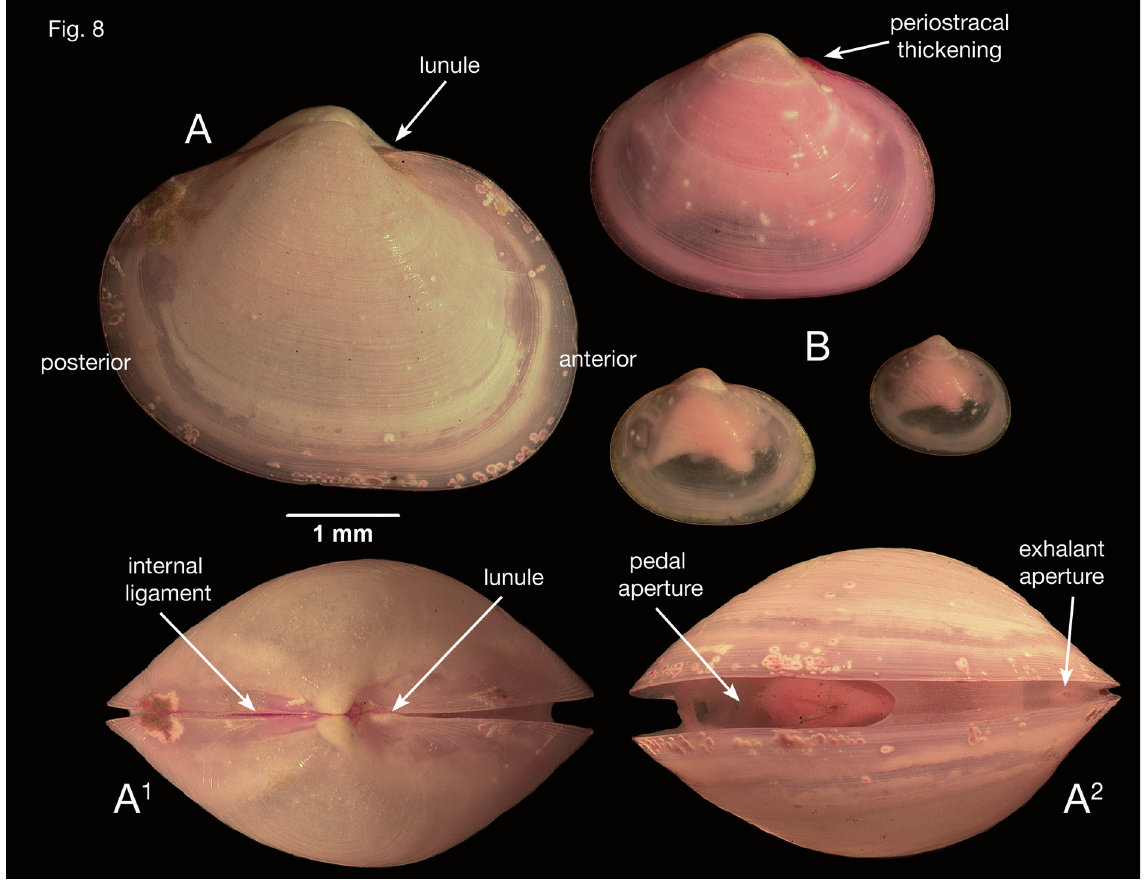
Fig. 8. Computer enhanced photomicrographs of whole specimens of Syssitomya pourtalesiana sp. nov. from the Norwegian Sea. A-A 2 . Holotype A . Exterior from right side. A 1 . Dorsal. A 2 . Ventral. B . Paratypes, size